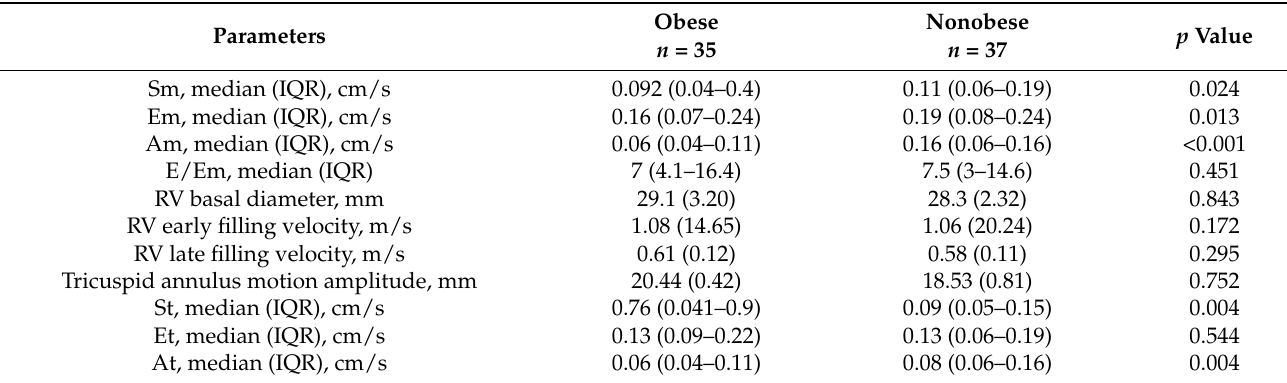
Figure 1. Comparison of the circumferential, radial strain of left ventricle ( A , B ) and longitudinal strain of left and right ventricle) ( C , D ), torsion, and normalized torsion of left ventricle ( E , F ) between obese and nonobese children. 3.4. Atrial Volumetric Data and 2D Strain Analysis The volumetric LA and RA data, the values of LA and RA strain are shown in Table 3. Only LA peak negative strain was significantly decreased in obese children ( p < 0.01). LA peak positive, total strain, RA peak negative and peak positive, and total strain did not differ between the obese and nonobese children. Volumetric analysis showed significantly increased minimal LAVi and RAVi (the volume indexes during atrial contraction) ( p < 0.001) as well as maximal LAVi and RAVi (the volume indexes at the end